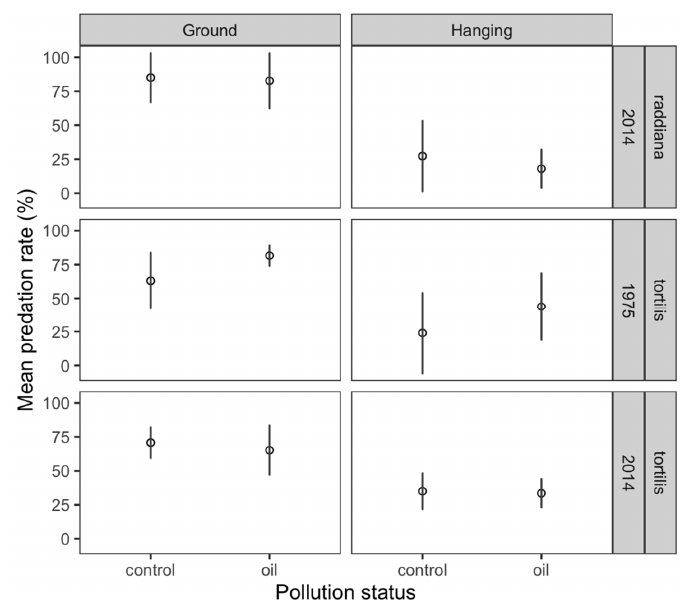
Figure 1. Mean predation rate (% ± SD) on seeds collected from oil-polluted (“oil”) and unpolluted (“control”) Vachellia tortilis and V. raddiana trees in the two sites of the experiment (1975 and 2014) and from the two habitats (ground and tree) in Evrona Nature Reserve, southern Israel. Contrary to our prediction, we found that the percentage of seeds predated in a pod was unrelated to the total number of seeds in the pod: V. raddiana , linear regression, t = −0.388, p = 0.698, and V. tortilis , linear regression, t = 0.503, p = 0.615. For predated seeds from fallen pods, the average number of holes per seed was 1.3 ± 0.58 (SD = 0.58, n = 1570). More than 80% of the predated seeds had a single hole, 14.5% had two holes, 4.6% had three holes, and 0.2% had four holes. A small fraction of the predated seeds (4.2%) were totally consumed. In fallen pods, we confirmed the previous observation that the same seed may host up to five bruchid individuals [34].